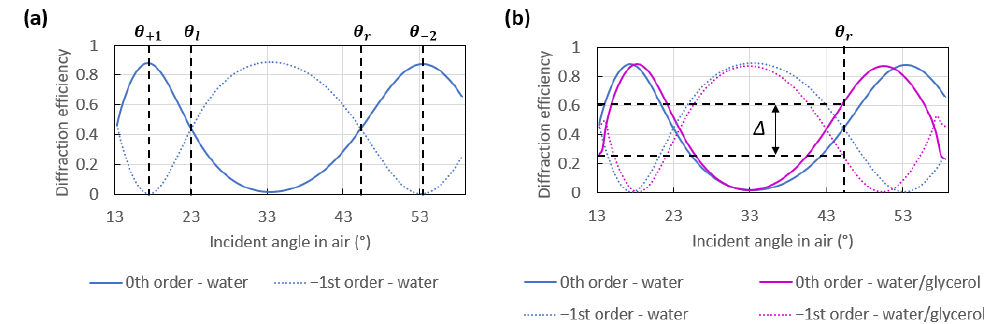
Figure 3. ( a ) Computed angular response of an ideal sinusoidal grating of period 770 nm and depth 228 nm, formed as a 100 nm-thick gold layer, covered by water ( n = 1.33), and under plane wave incidence at λ 0 = 850 nm. The diffraction efficiencies of the 0th and − 1st orders produce a switching pattern as the angle of incidence is varied. ( b ) Computed angular response for a cover solution comprised of water and glycerol ( n = 1.35, pink curves) for the same grating in part ( a ). The difference in the diffraction efficiencies of the 0th and − 1st orders, ∆ , at θ r is no longer zero (as it was for water, n = 1.33, blue